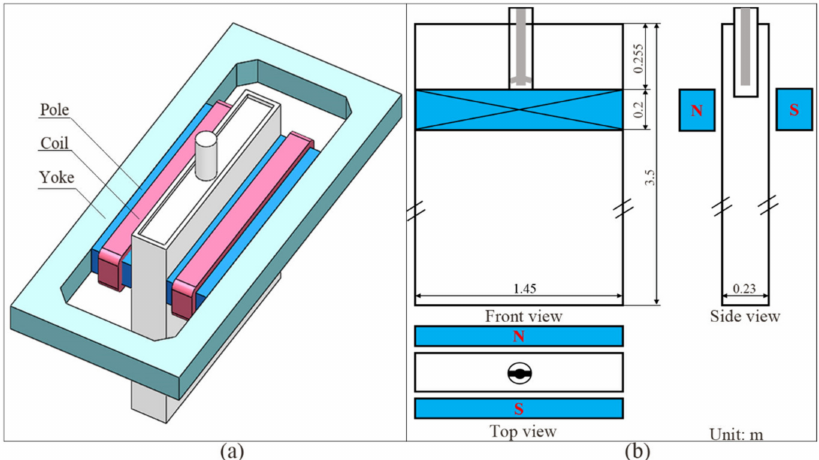
Figure 1. Schematic diagram of ruler EMBr device: ( a ) schematic of ruler EMBr device and ( b ) plane view of ruler EMBr